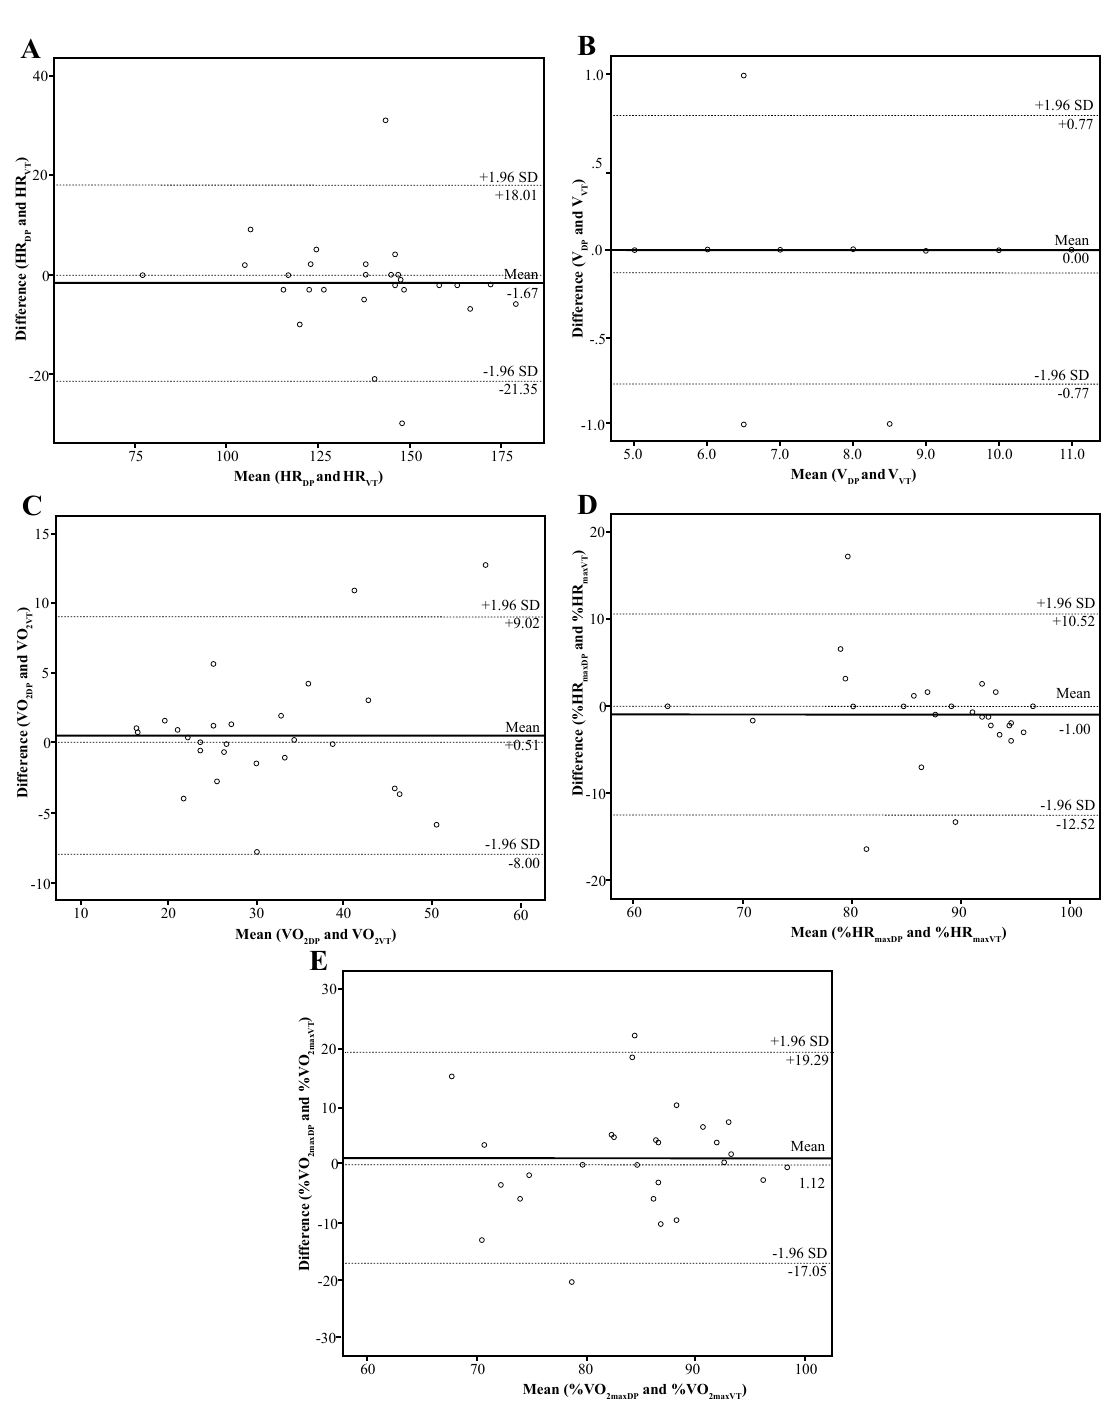
) (in %) (D), and percentage of maximal VO2 (%VO max